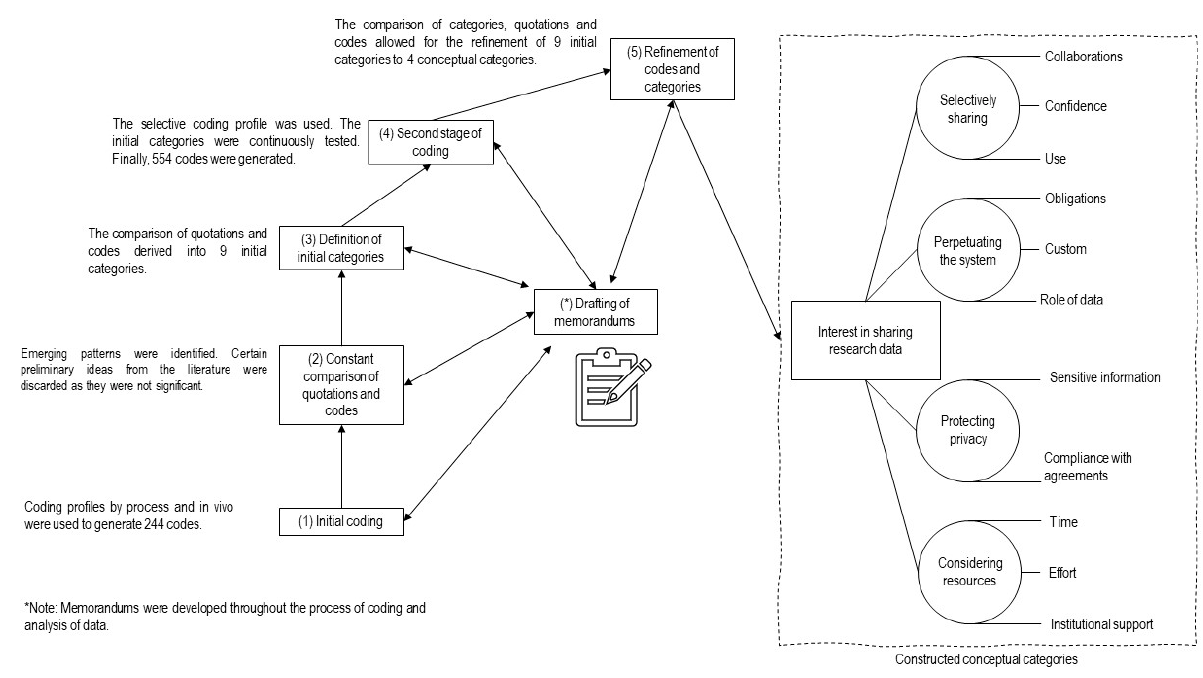
Figure 3. Overview of the process of data analysis.